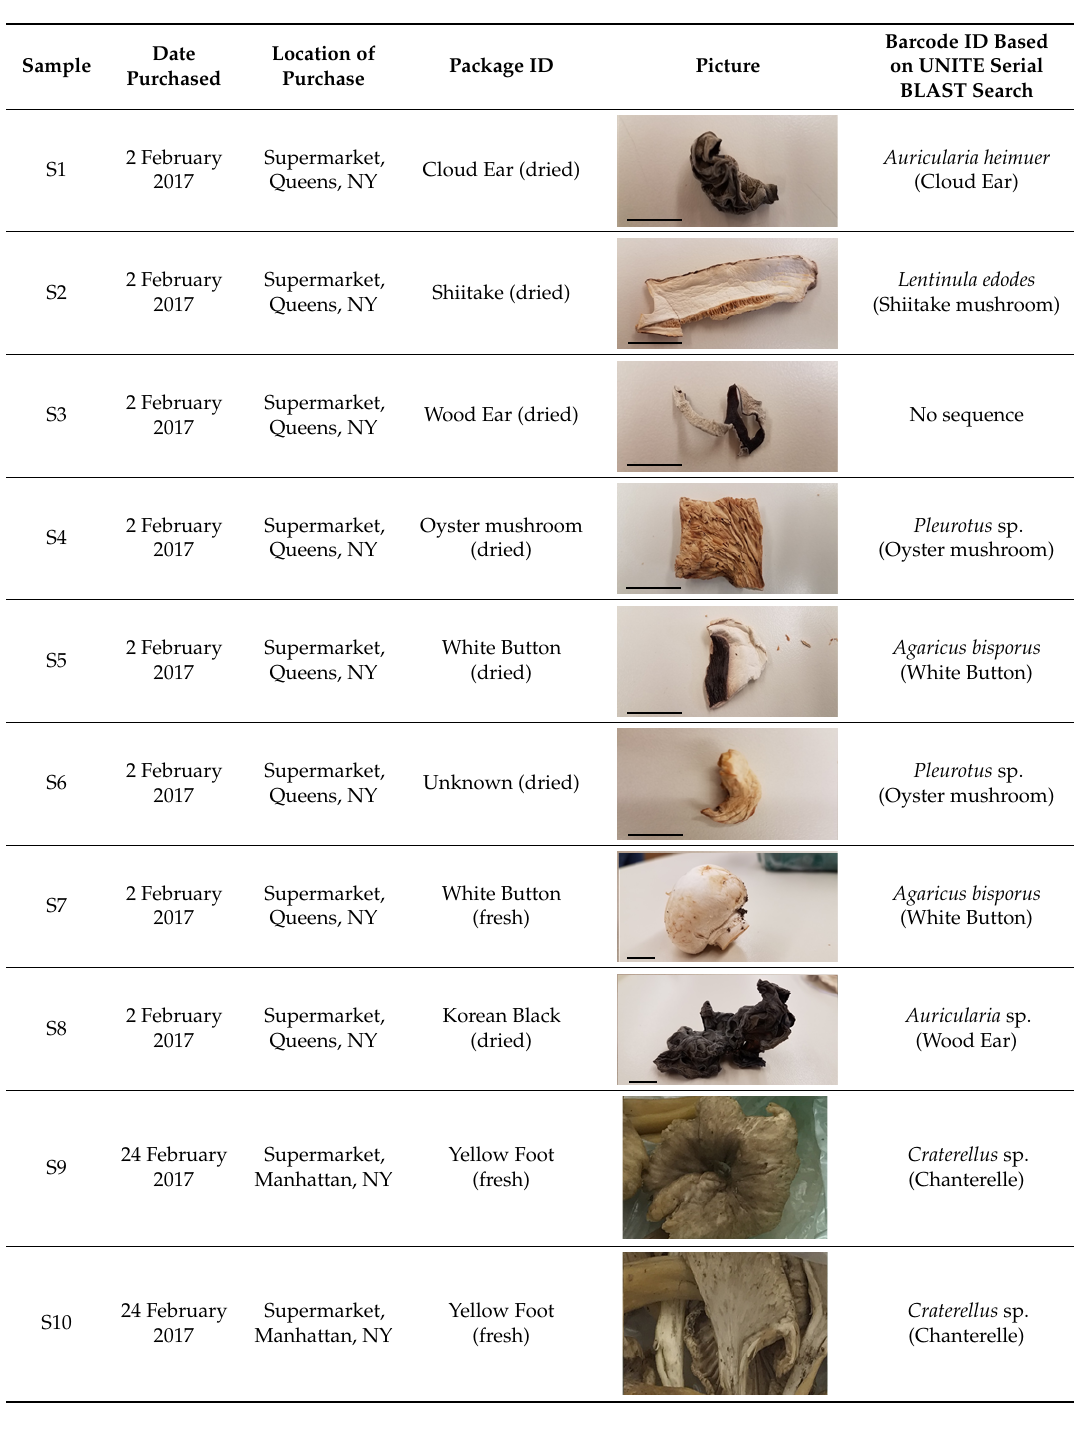
Table 1. List of fungi sampled in this study for internal transcribed spacer (ITS) barcoding. The taxonomic identifications (ID) of the samples based on the User-friendly Nordic ITS Ectomycorrhiza Database (UNITE) serial Basic Local Alignment Search Tool (BLAST) search for ITS barcodes and common names are indicated. Samples S1–S6 were derived from the bag of “Dried Stir Fry Mushroom Blend”. Sample S8 was derived from the bag of “Dried black mushrooms.” Scale bar indicates approximately 1 cm. Scale bar for samples S9 and S10 is not